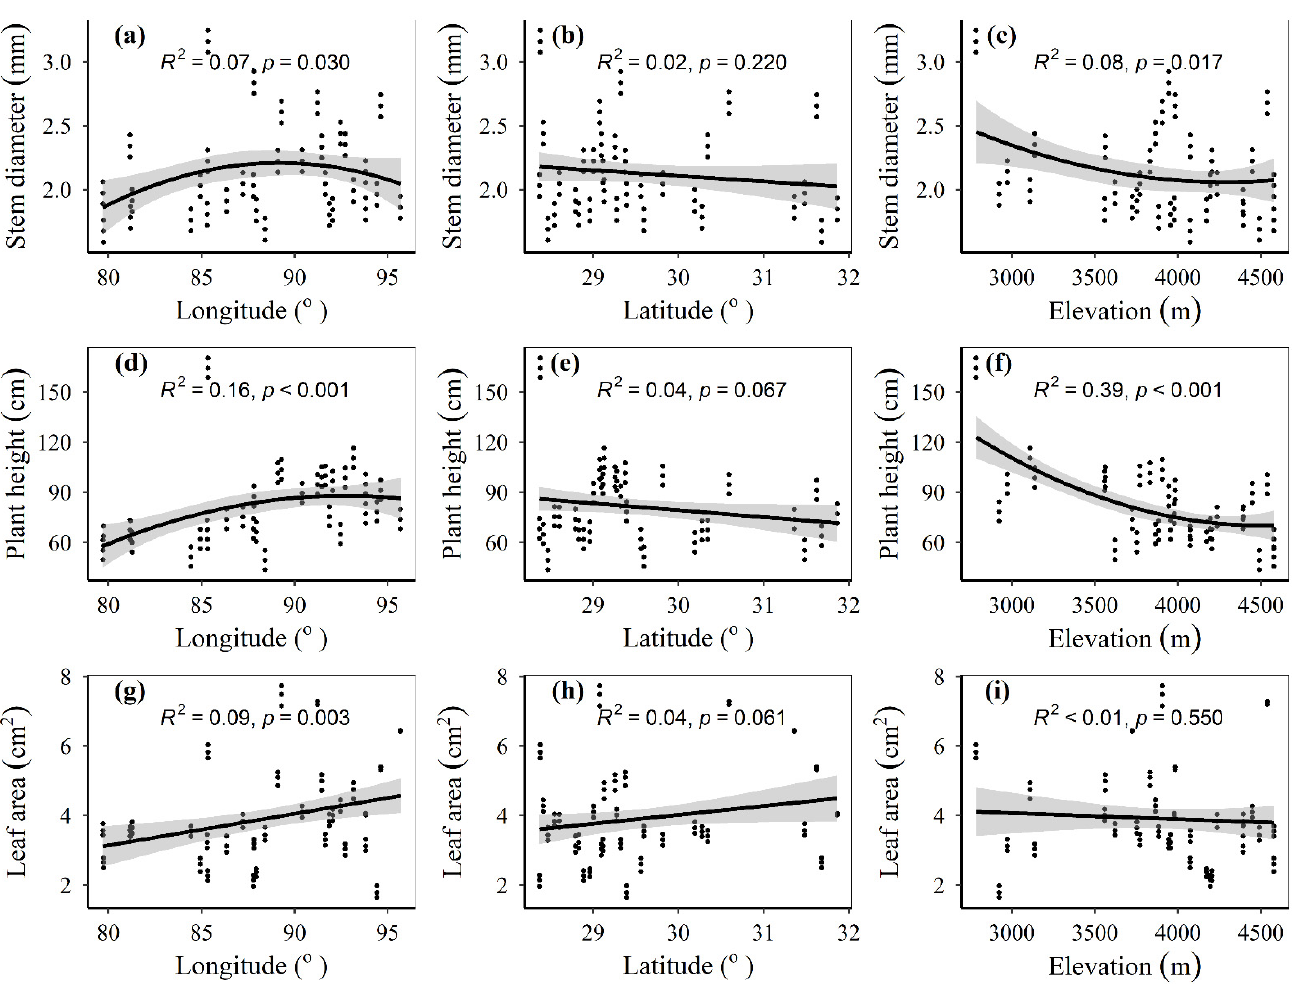
Figure A3. Relationships between ( a ) stem diameter and longitude, ( b ) stem diameter and latitude, ( c ) stem diameter and elevation, ( d ) plant height and longitude, ( e ) plant height and latitude, ( f ) plant height and elevation, ( g ) leaf area and longitude, ( h ) leaf area and latitude, and ( i ) leaf area and elevation.